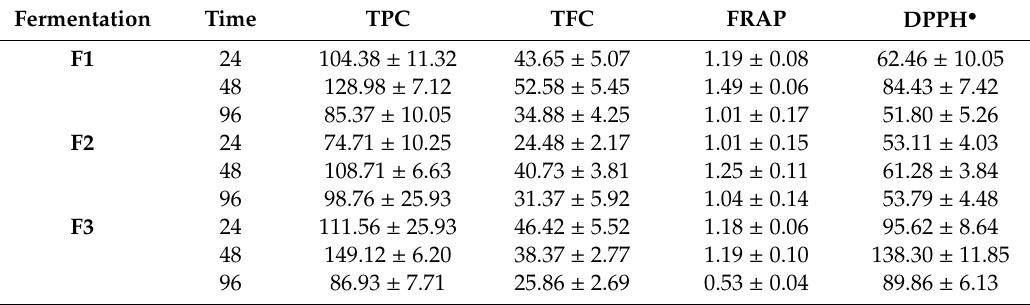
Experiment 2: cowpea-beans flours fermented under conditions of 30% of moisture. TPC—expressed as µ g of gallic acid equivalents (GAE) / 100 mg of flour dry matter (DM); TFC— µ g of catechin equivalents (CAE) / 100 mg of flour DM; FRAP— µ mol ferrous sulphate equivalents (FSE) / 100 mg of flour DM; DPPH • — µ g of trolox equivalents (TE) / 100 mg of flour